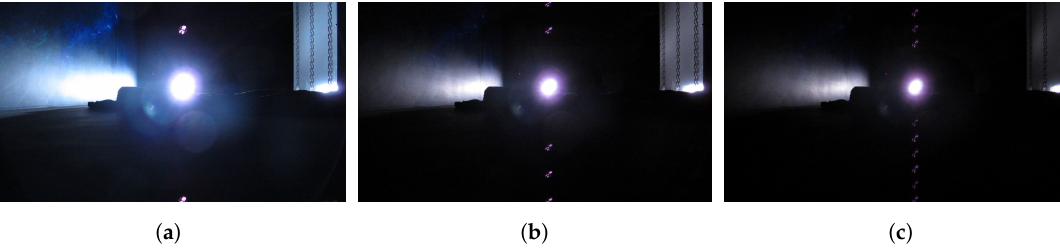
Figure 6. CCD smear dots. The video frame rate is 23.976 fps and the rates of the stroboscope are set as 47.95 ( a ); 191.81 ( b ); and 333.33 ( c ) flashes per second separately.